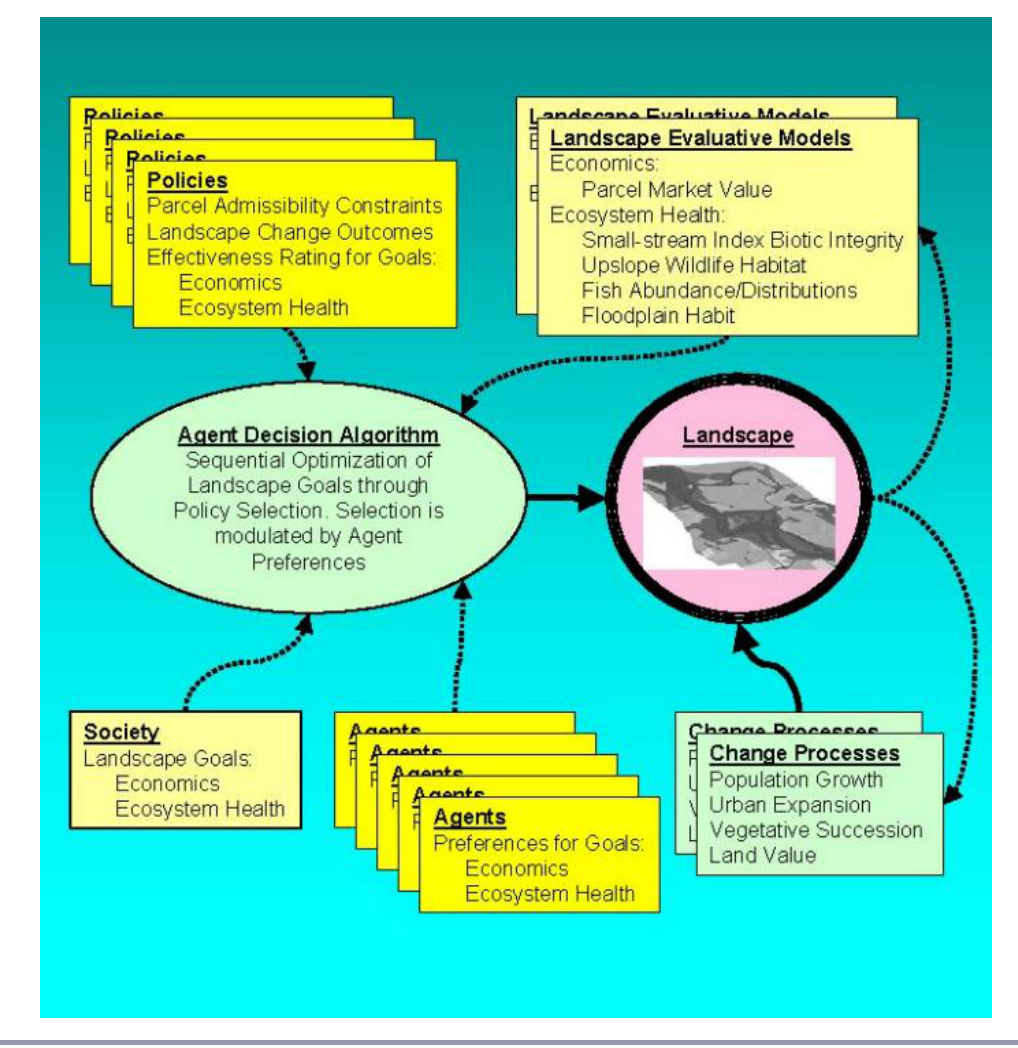
Fig. 1 . Conceptual framework showing the major components and relations of the social-ecological system represented in the Evoland model. The dashed arrows indicate flows of information. The solid arrows indicate changes to the landscape. The agent decision-making process, which is repeated annually for each parcel, is tantamount to stochastic sequential optimization of the landscape for societal goals and agent preferences. The process begins when the agent selects the subset of policies admissible on the current parcel, e.g., riparian policies for riparian parcels. Next, admissible policies are ranked on the basis of policy effectiveness ratings. One rating for each of the ecosystem health and economic values indicates the capacity of the policy to change the landscape on that metric. Two factors contribute to the highest rankings. One is the match between policy ratings and agent preferences. The other depends on the magnitude of the landscape deficiencies and the capacity of the policy to correct them; this factor is proportional to the magnitude of the deficiencies. Finally, one of these policies is chosen stochastically, with the highest ranking policy the most likely to be selected. A landscape evaluation provides feedback to the decision algorithm regarding deficiencies. Other change processes do not involve agent decision making directly, but do cause landscape changes that affect the landscape